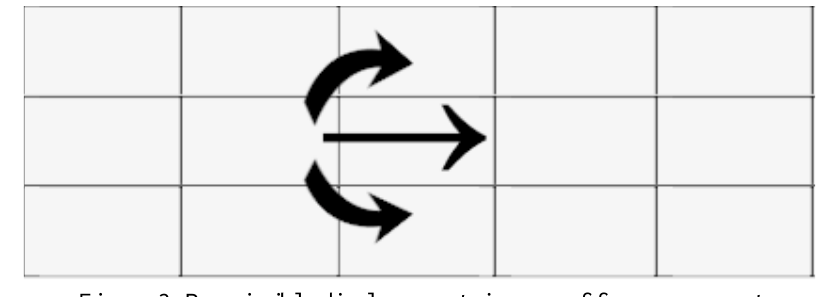
Figure 3. Permissible displacements in case of free